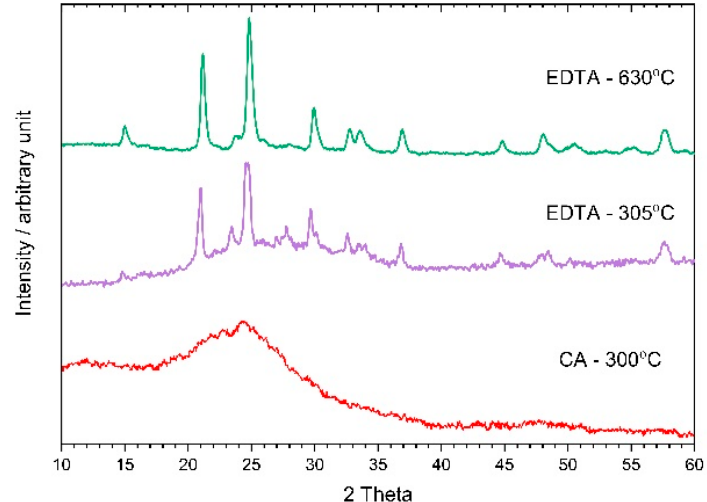
Figure 3. The phase evolution during the thermal process of the EDTA-assisted gel at three different temperatures. Higher temperature treatment can cause a higher level of crystallization without any influence on the phase composition of the sample. A diffraction pattern of the CA-assisted gel at 300 °C was also added for comparison.